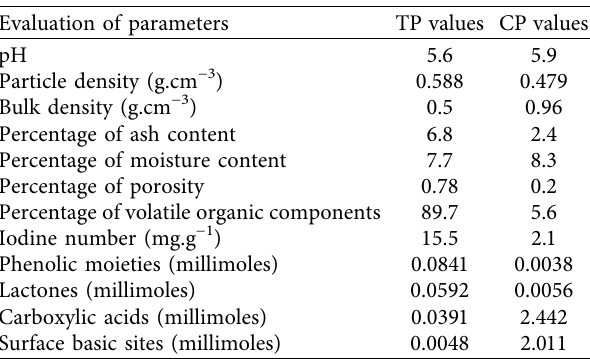
Table 1: Physicochemical characterization of both biosorbents.